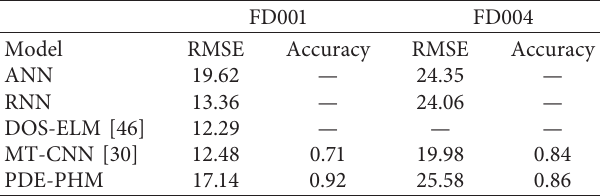
Figure 7: Latent variable classifier decision zones based on a trained random forest model for the FD001 and FD004 subdatasets: degraded state (red) and healthy state (blue). (a) FD001 train. (b) FD001 test. (c) FD004 train. (d) FD004test. Table 5: Comparison with the state-of-the-art results for RUL RMSE values and state of health classification accuracy for the FD001 and FD004 test